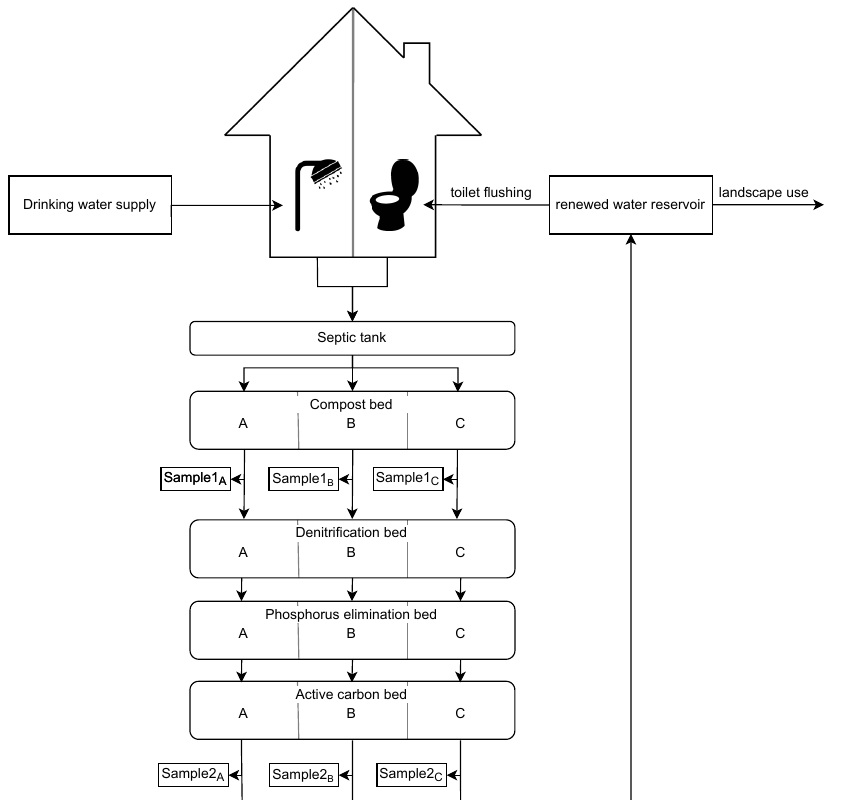
Figure 1. Scheme of the pilot plant. The process is conducted under three different daily hydraulic loads: A for 70, B for 100, and C for 130 l/m 2 .